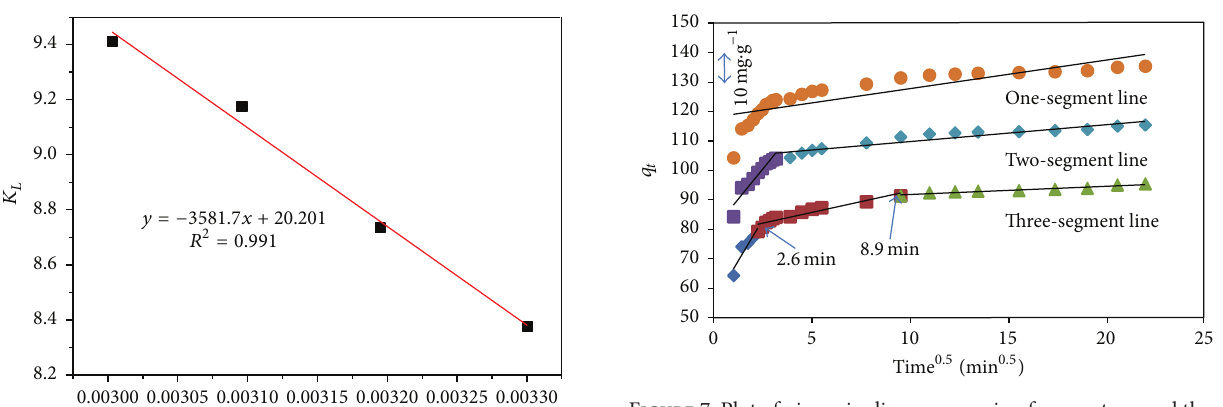
Figure 7: Plot of piecewise linear regression for one, two, and three segments in the Webber plot. Experimental condition: initial AB concentration: 200 mg L −1 , mass of diatomite: 2.0 g, and tempera- ture: 25 ± 1 ∘